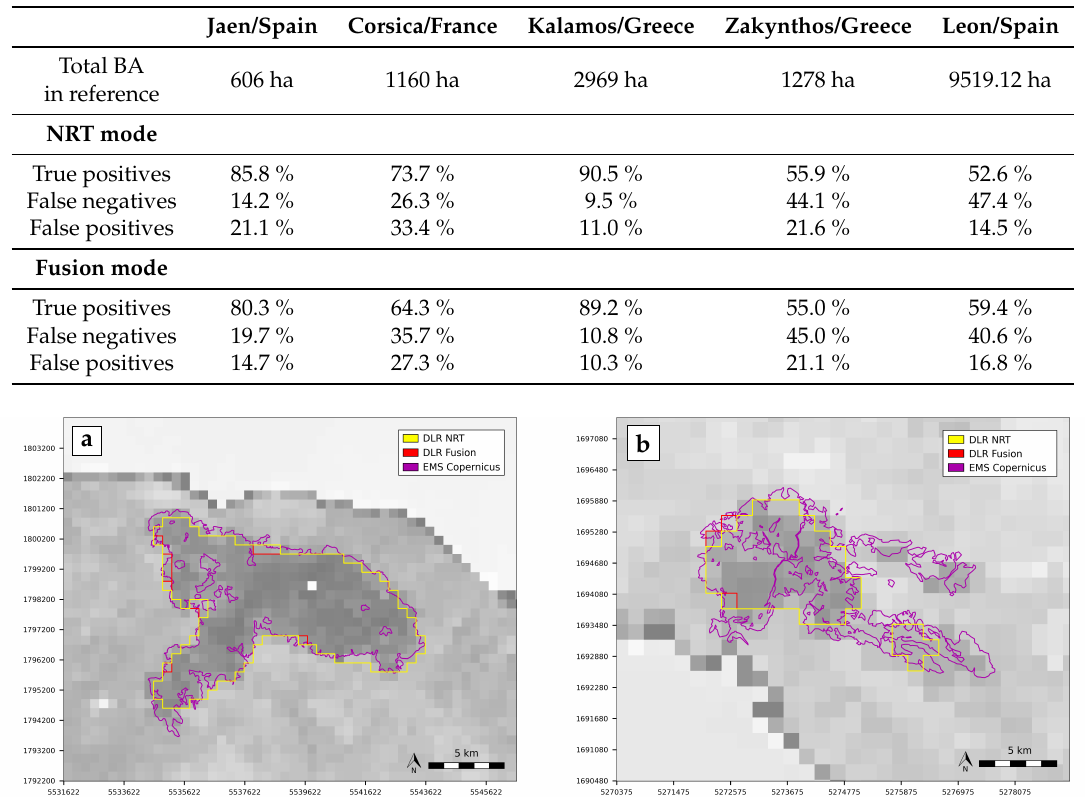
Table 2. Single incident analysis: validation of Sentinel-3 OLCI results with Copernicus Emergency Mapping Service data.